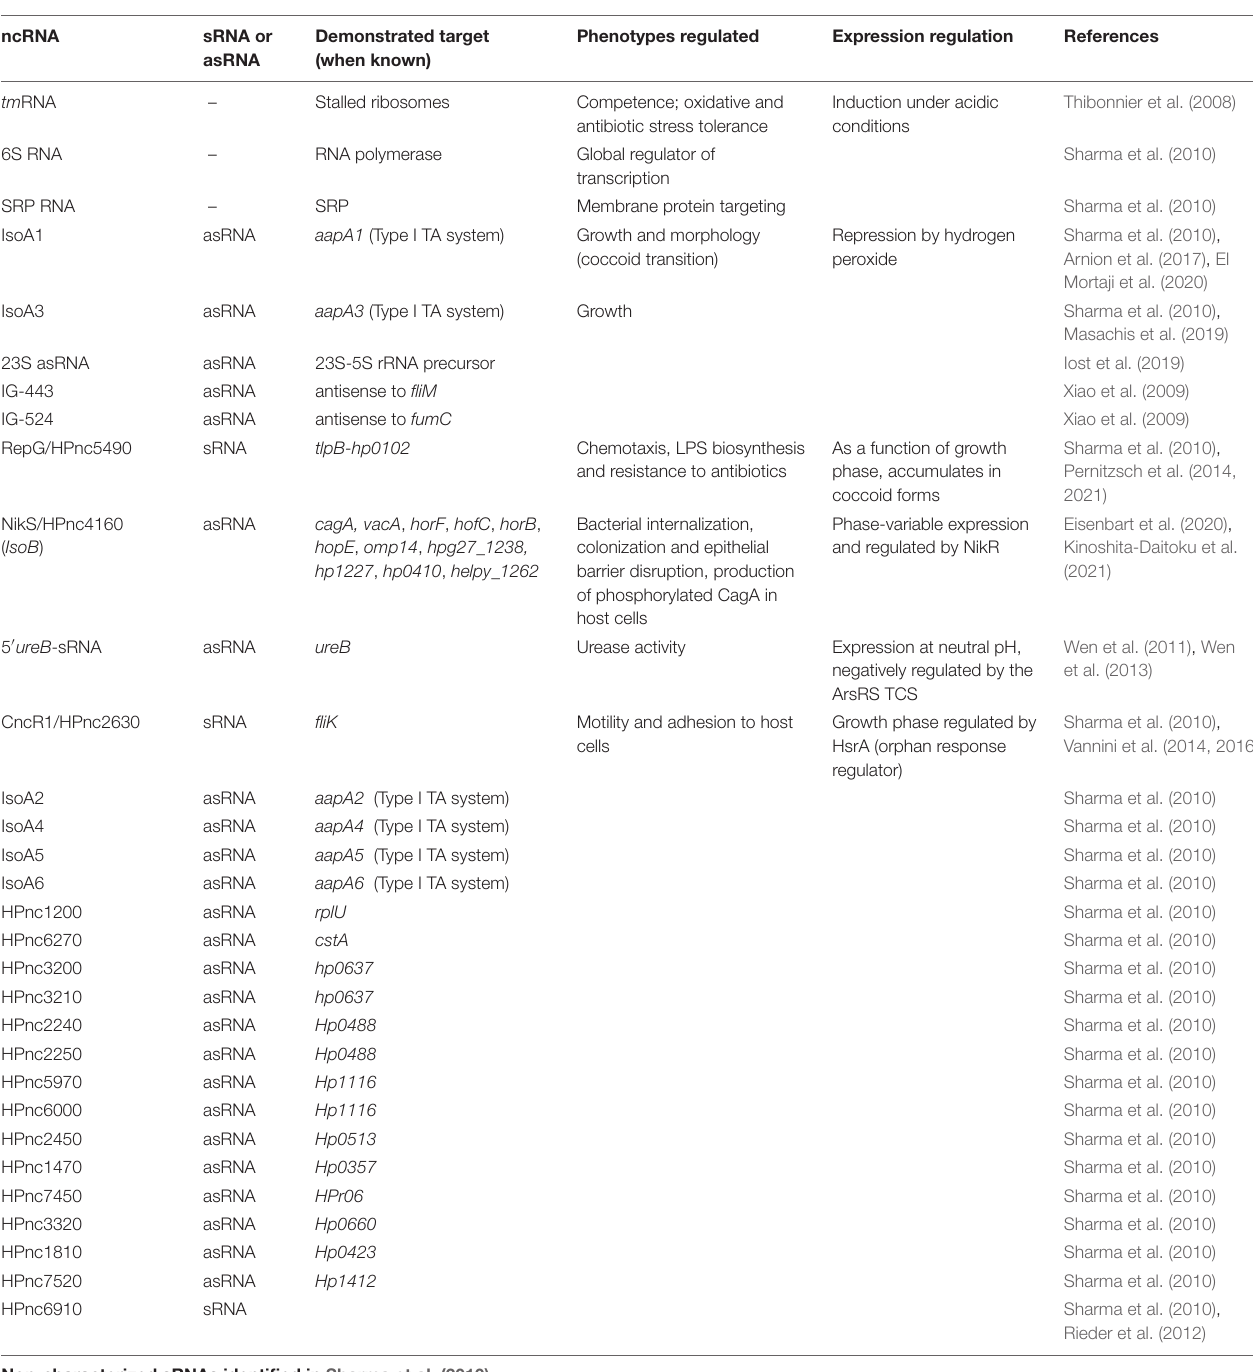
TABLE 1 | List of non-coding RNAs (ncRNAs) validated (visualized by Northern blot) in Helicobacter pylori .